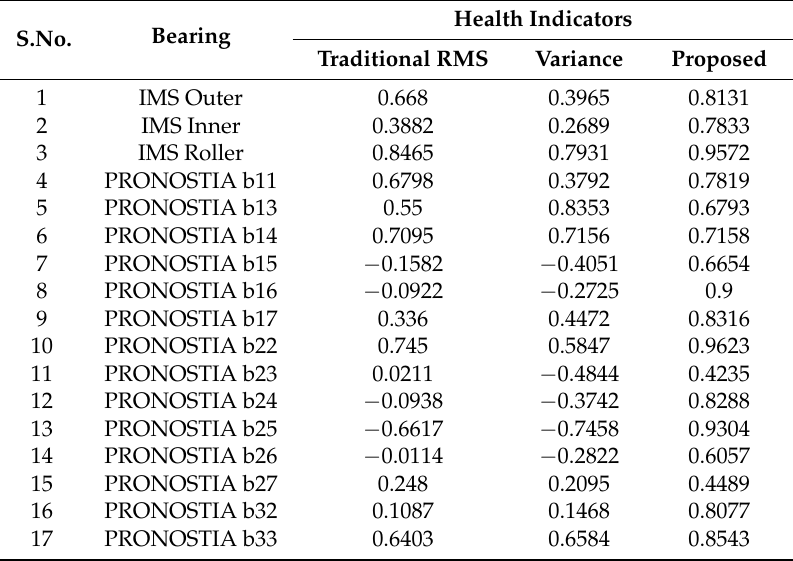
Table 3. Quantitative Evaluation of the Health Indicators using Trendability.